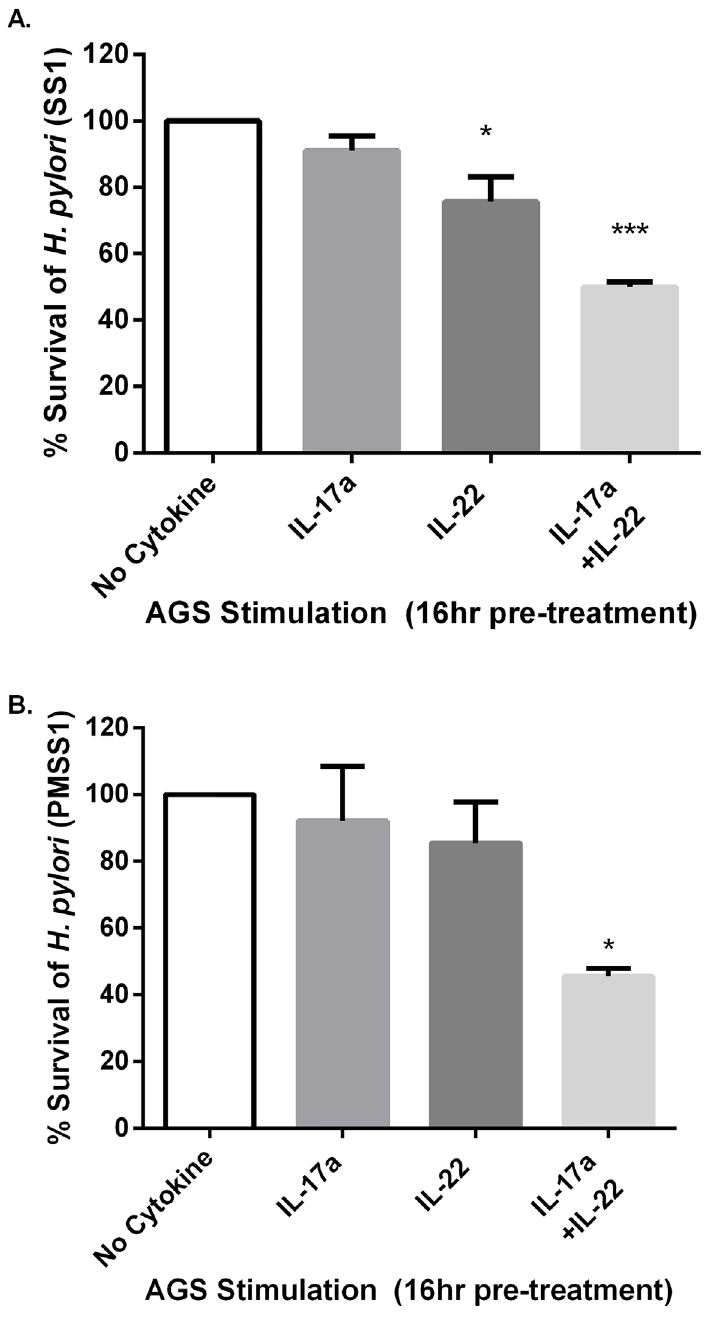
Fig 2. IL-17A and IL-22 can activate human gastrointestinal epithelial cells to kill H . pylori . The ability of H . pylori to survive for 6 hours in co-culture with AGS cells pre-stimulated for 16 hours with IL-22, IL-17A or combined IL-22 and IL-17A is presented. (A) SS1 strain or (B) PMSS1 strain percent (%) survival represented on the y-axis is equal to the number of H . pylori CFU from the cytokine-treated cells divided by the number of CFU recovered from untreated AGS cells. Graphs are representative of 3 independent experiments and error bars represented mean ± SEM. Statistical significance is based on one-way ANOVA test with Dunnett ’ s correction for multiple comparisons to the no cytokine treatment control *** p < 0.001, ** p < 0.01, * p < 0.05.